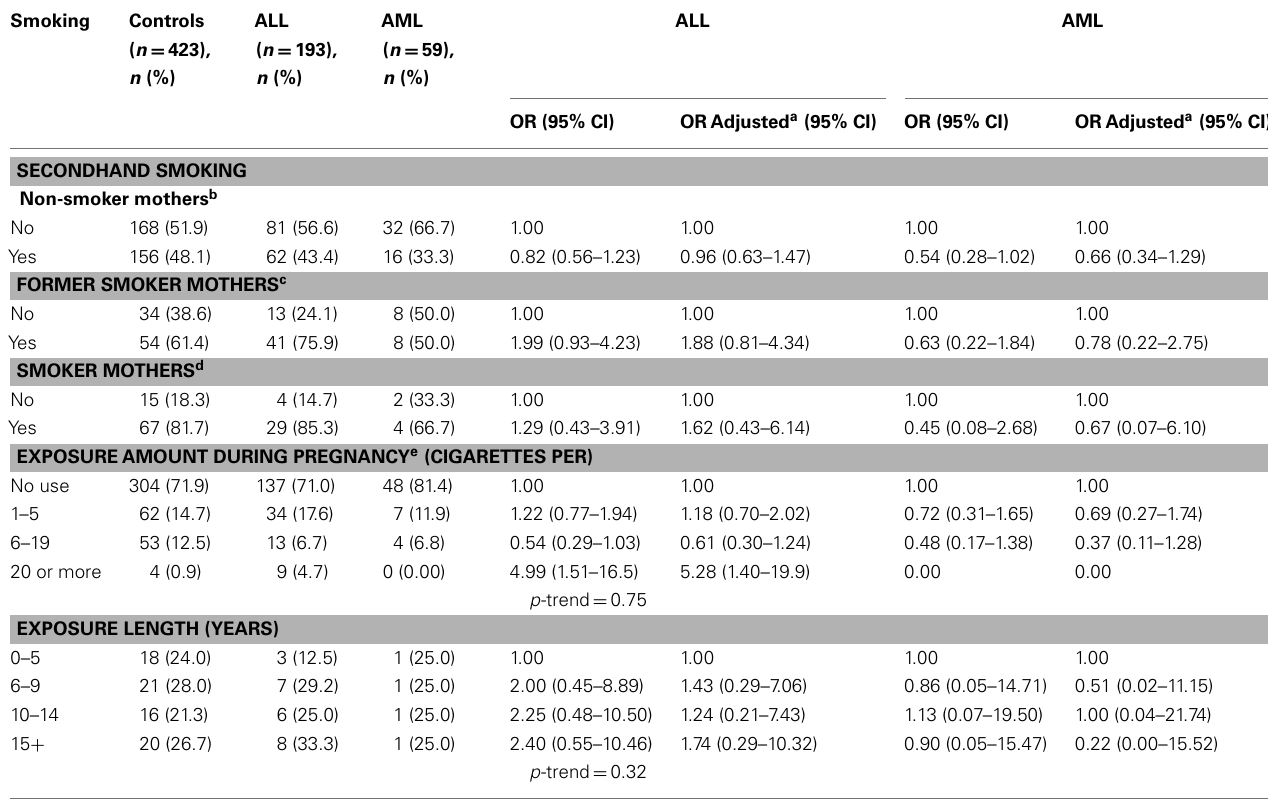
Table 3 | Secondhand maternal smoking, cigarettes consumption amount and duration of tobacco exposure, leukemia cases, and control mothers, children < 2year, Brazil,